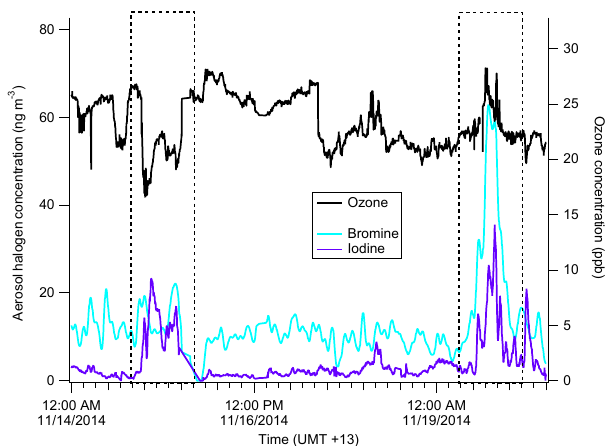
Figure 10. Time series of iodine (purple) and bromine (light blue) from the AMS as well as gas-phase ozone concentration